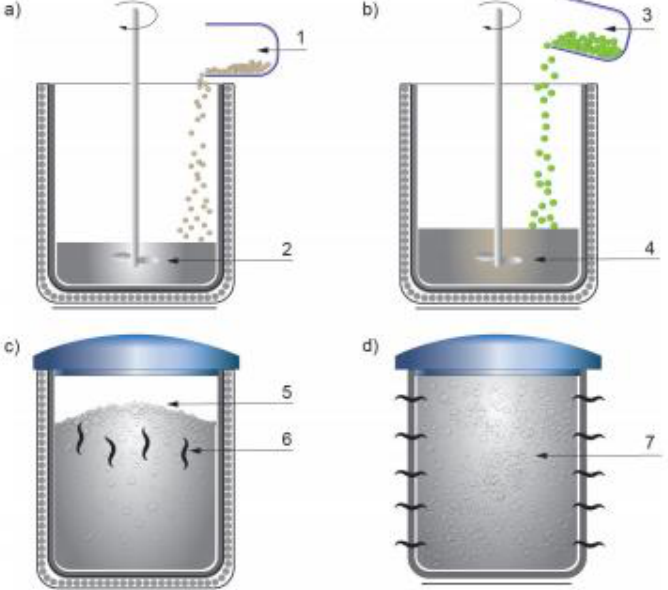
Figure 7. Scheme of the foaming method in the liquid state: ( a ) thickening, 1—Ca additive, 2—liquid aluminum; ( b ) 3—foaming agent TiH2, 4—thickened aluminum; ( c ) foam formation as a result of the chemical reaction, 5—foamed aluminum, 6—foam drainage; ( d ) foam cooling, 7—finished product of aluminum foam (own elaboration based on [39–41]).